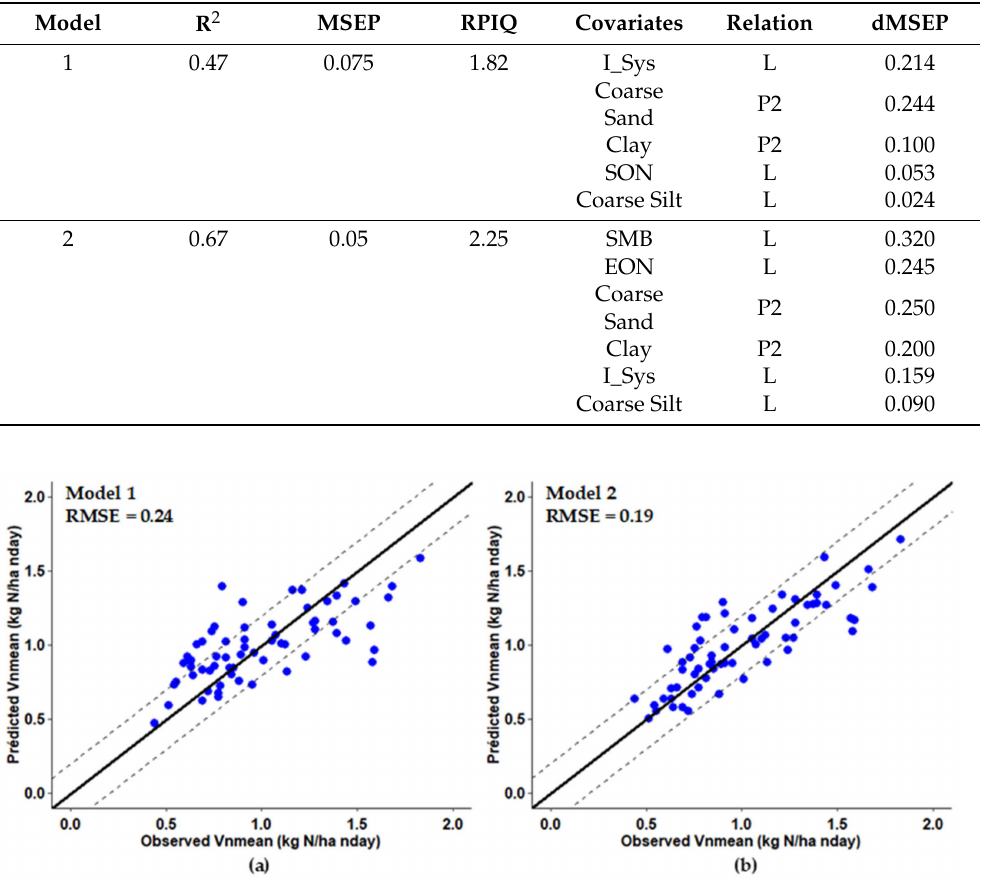
Figure 6. Comparison of observed Vn mean to that predicted by ( a ) model 1, whose covariates were the basic soil parameters and I_Sys, and ( b ) model 2, with SMB and EON as additional variables. Solid lines are 1:1 lines, while dashed lines indicate ± 0.2 kg N ha − 1 nday − 1 around each 1:1 line. (RMSE: Root Mean Square